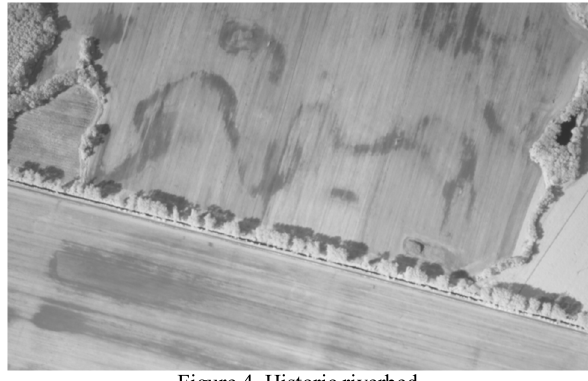
Figure 4. Historic riverbed